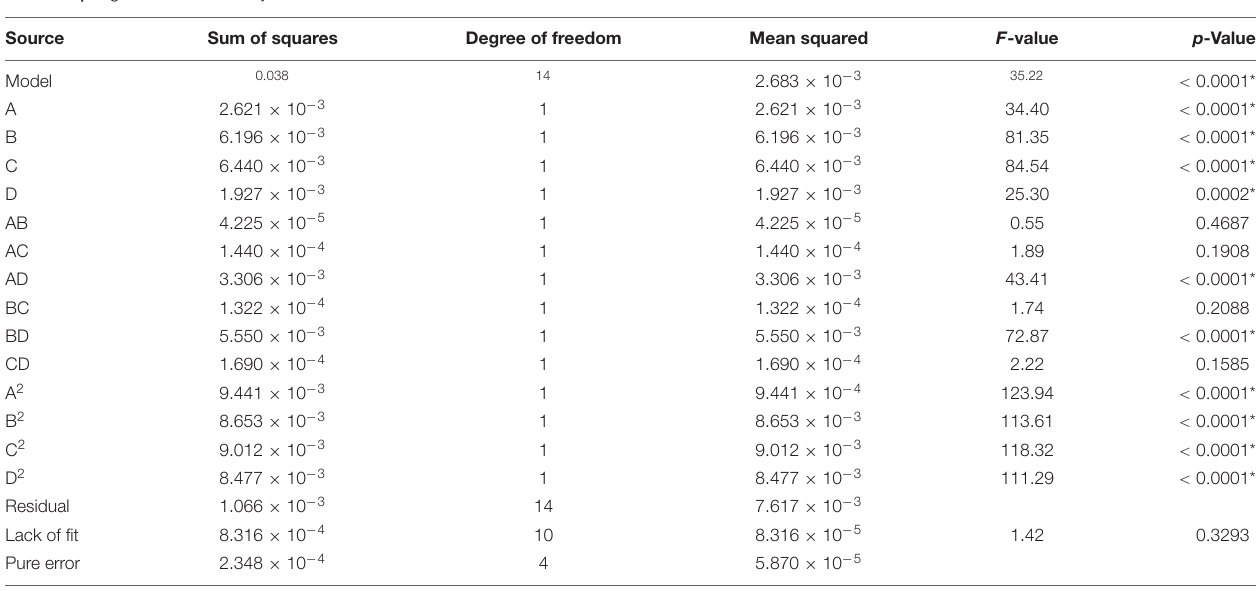
TABLE 2 | Regression model analysis of